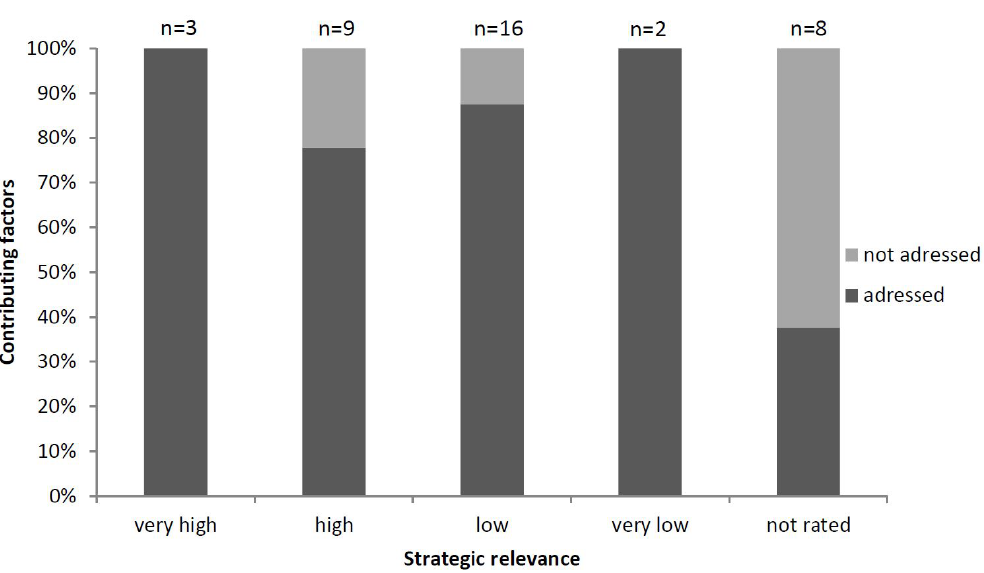
Figure 10. Contributing factors addressed directly by FSC and categorized according to their strategic relevance (1 = low, 4 =